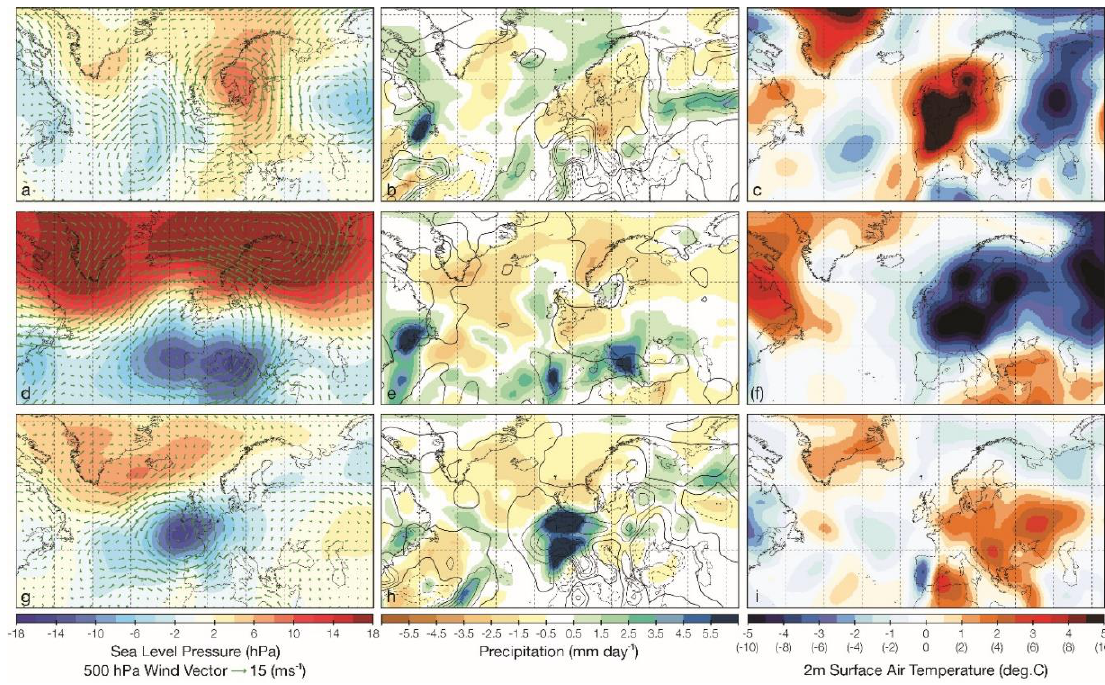
Figure 5. Composites of daily 500 hPa wind speed and direction anomalies and near-surface precipitation and mean temperature anomalies of the ten record: ( a – c ) TXx; ( d – f ) TNn; and ( g – i ) precipitation days. Data are from the Twentieth Century Reanalysis v2c [20] with the climatology base period as 1981–2010. One TXx record was set in 2015, outside of the reanalysis temporal period, so the 11th record value was used. Contours on plots b, e and h represent Convective Available Potential Energy anomalies, with solid (dashed) lines indicating positive (negative) anomalies at intervals of 40 J·kg −1 , with the zero contour enhanced. The second row of temperature anomalies for the right hand panels are the scale for plot f.